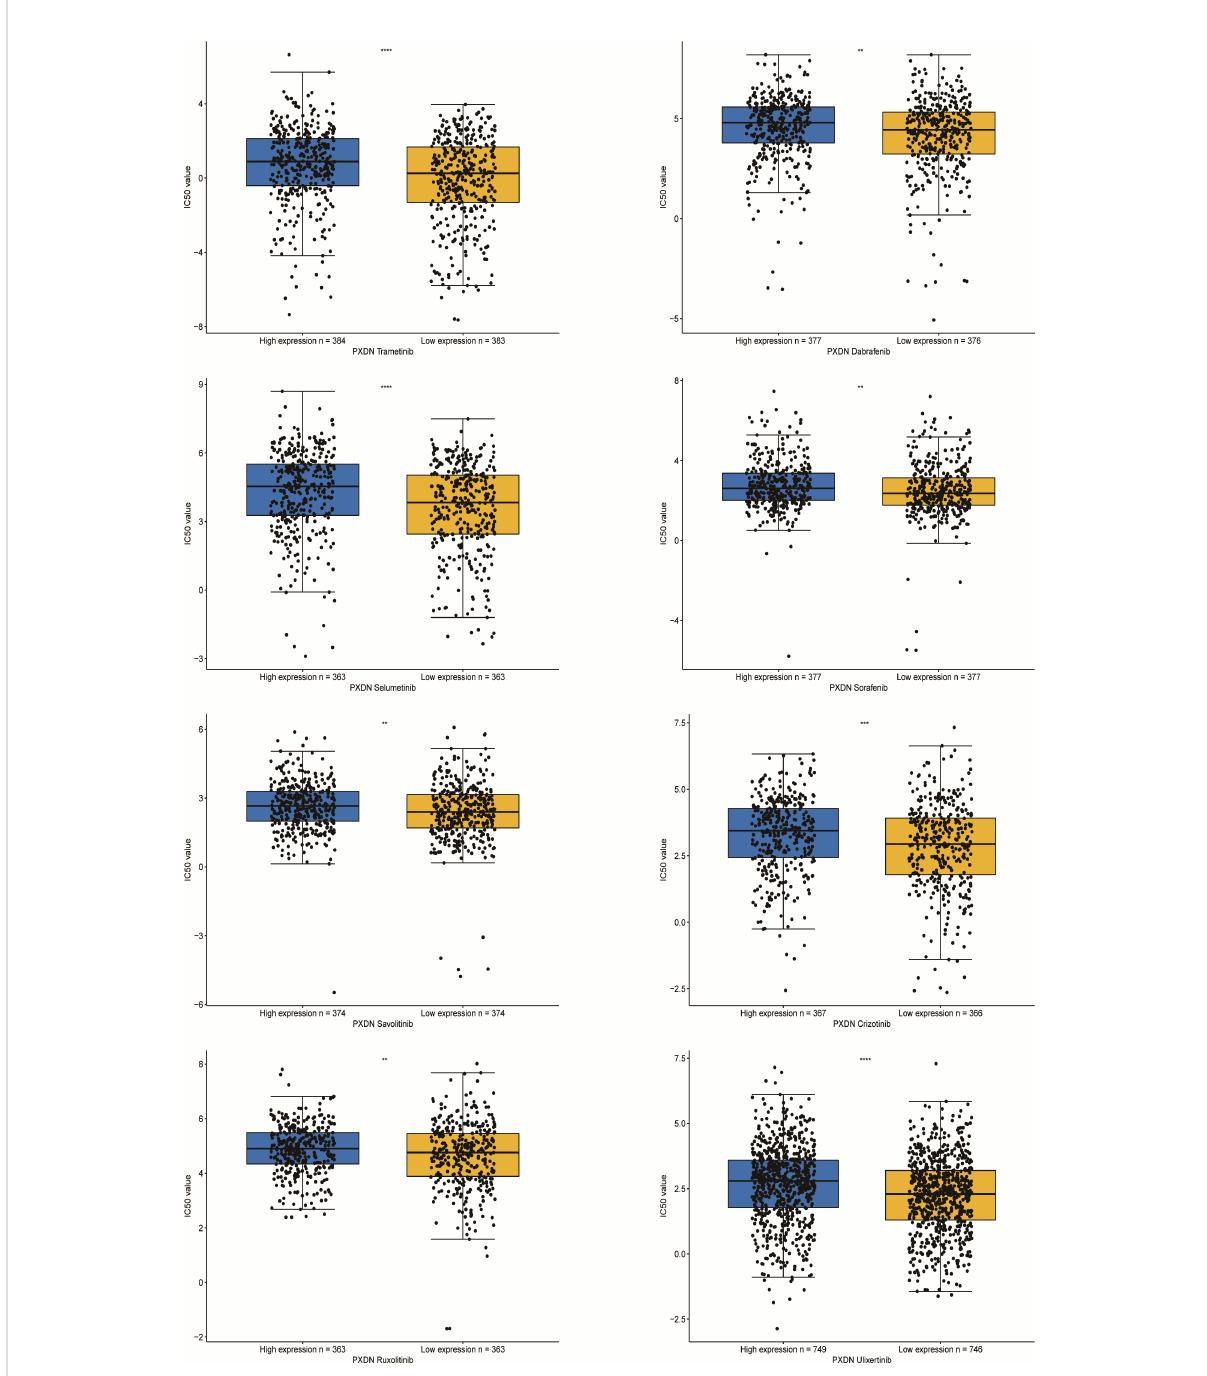
FIGURE 12 IC50s for different therapeutic drugs in the PXDN expression subgroups. **p < 0.01, ***p < 0.001, ****p <